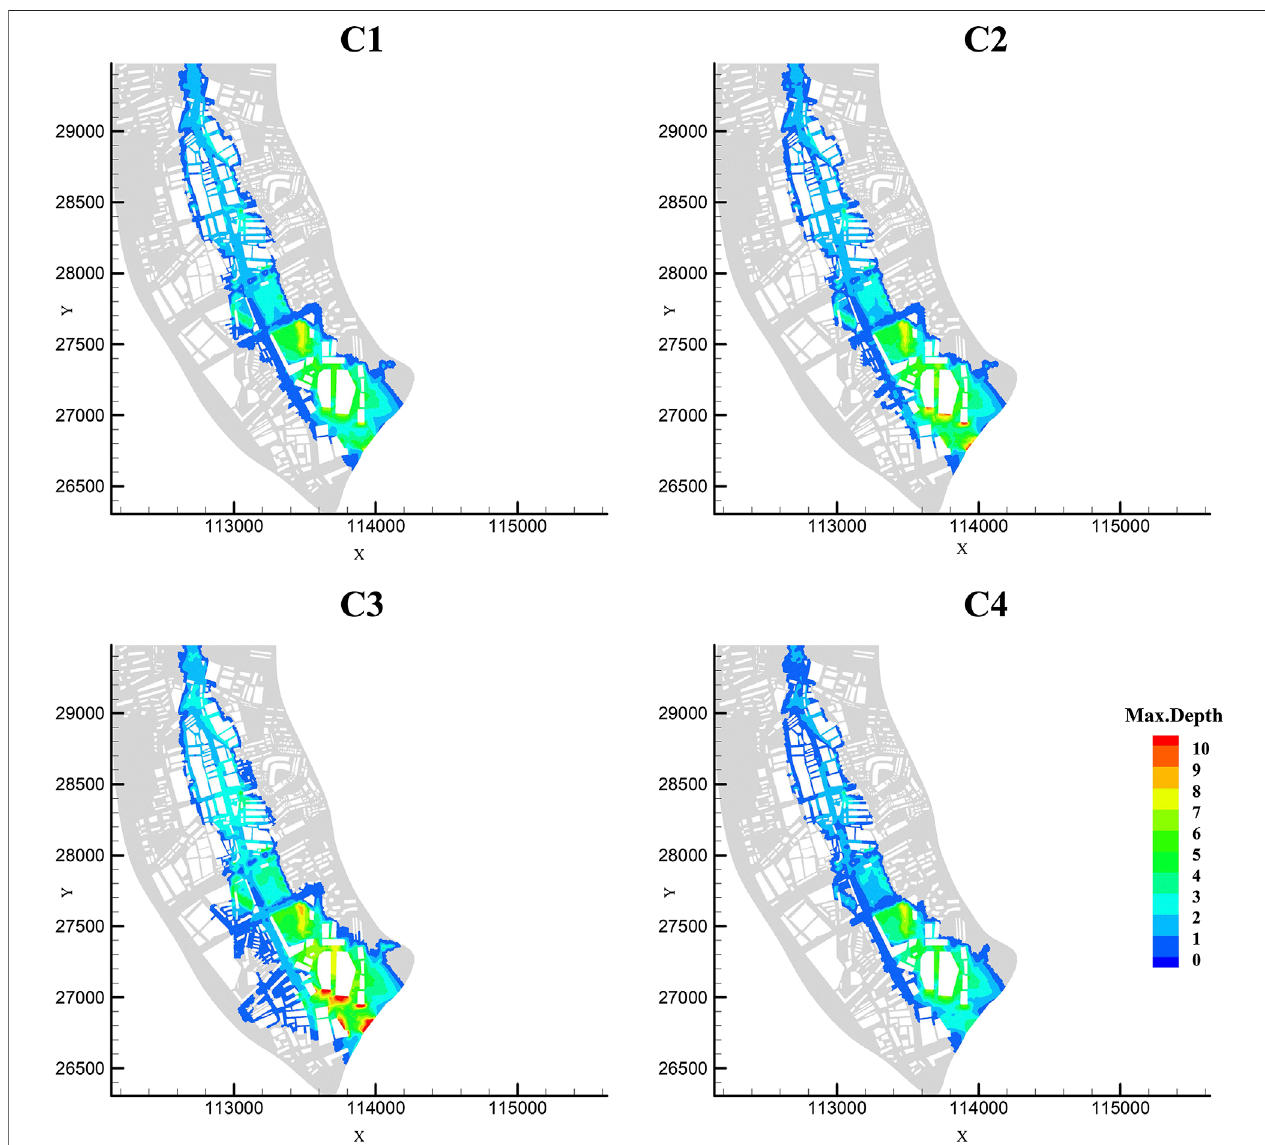
FIGURE 4 | Maximum submerged depth under different failure conditions (C1 –